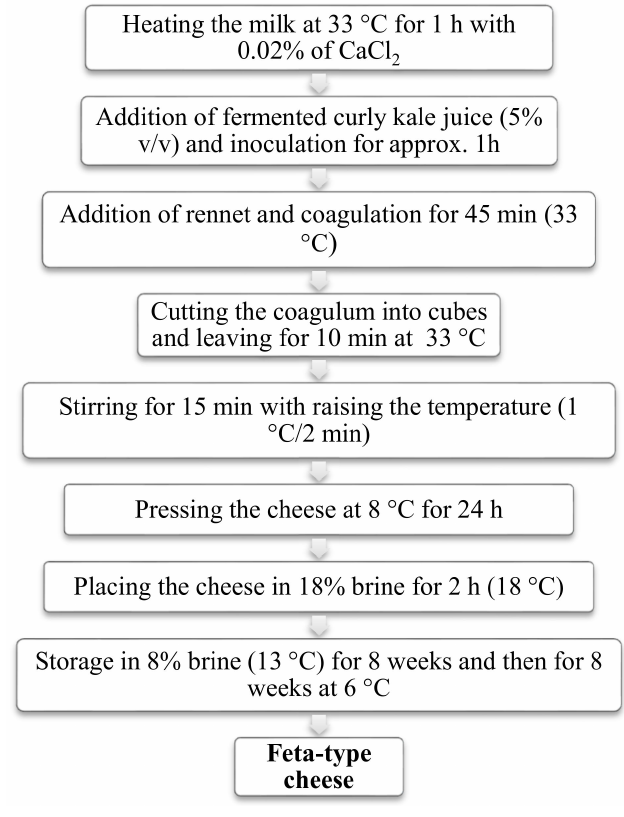
Figure 1. Diagram of Feta-type cheese